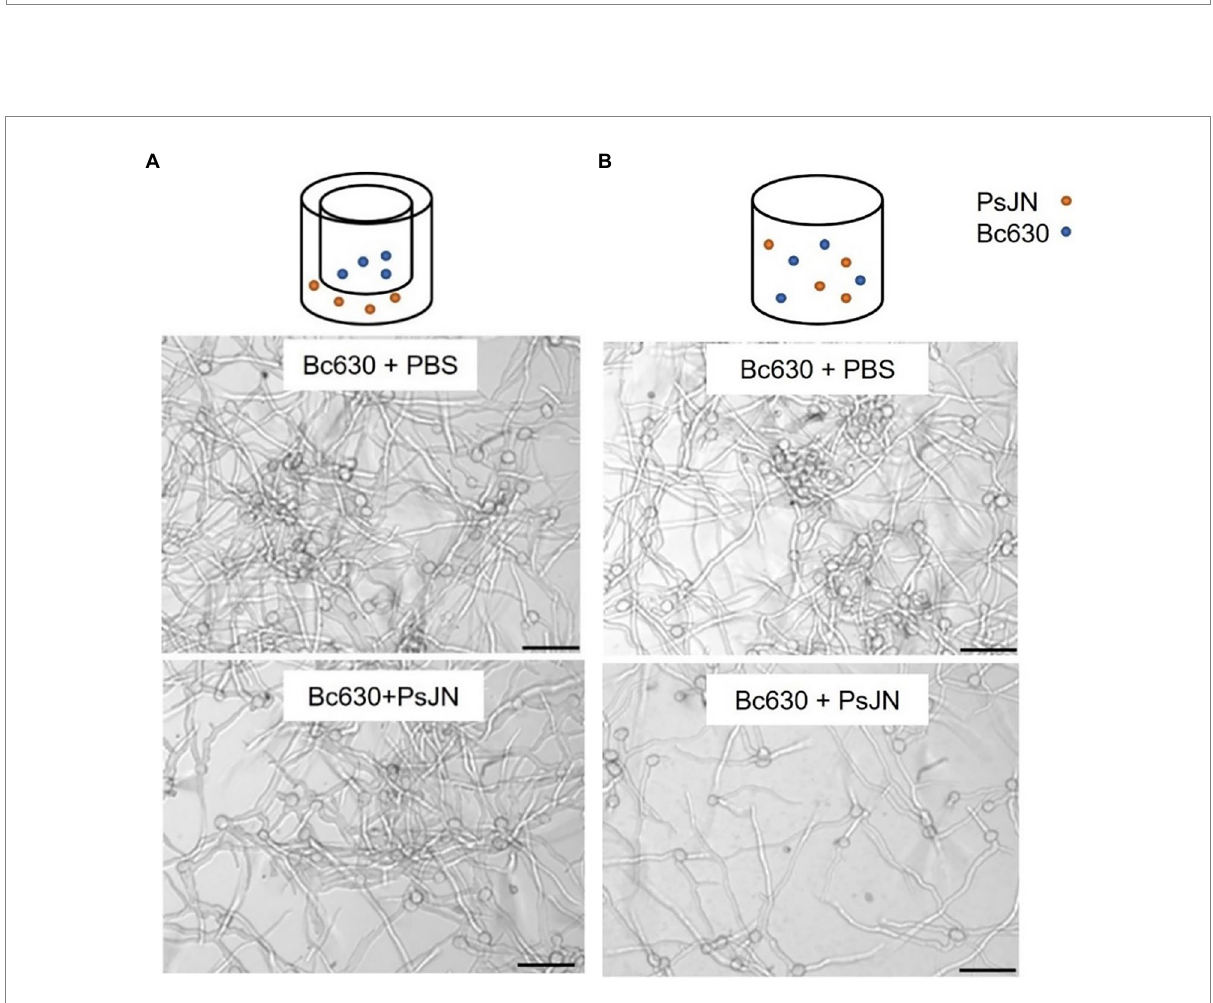
FIGURE 3 Direct antifungal effect of P. phytofirmans PsJN on B. cinerea spore germination with (A) or without (B) contact between the microorganisms. Observations were realized under inverted microscope 24 h after co-inoculation of PsJN (10 6 CFU ml − 1 ) and B. cinerea (5 × 10 4 conidies ml − 1 ). Scale bars = 50 μ m.